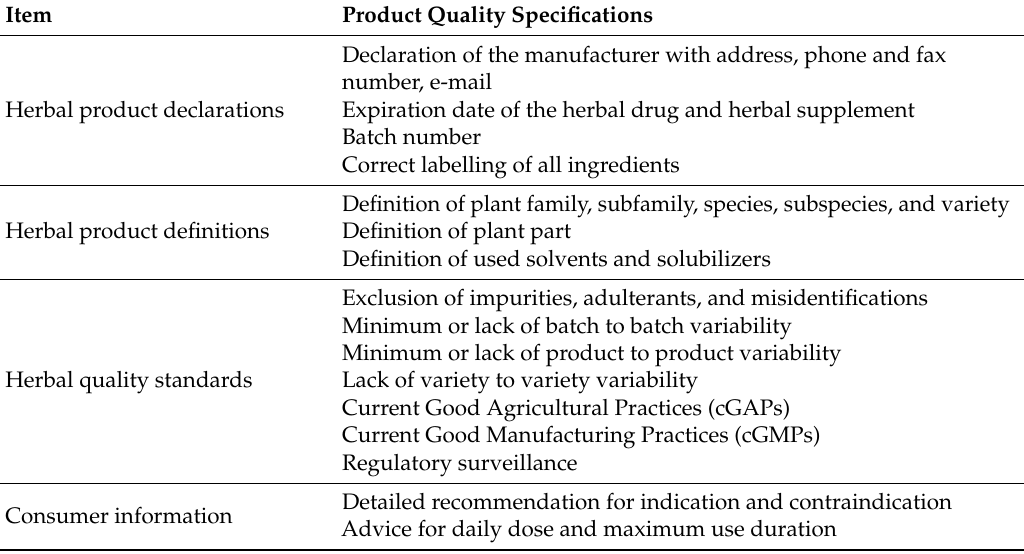
Table 1. Minimum quality requirements for herbs, herbal drugs, and herbal dietary supplements in the context with suspected herb induced liver injury (HILI)